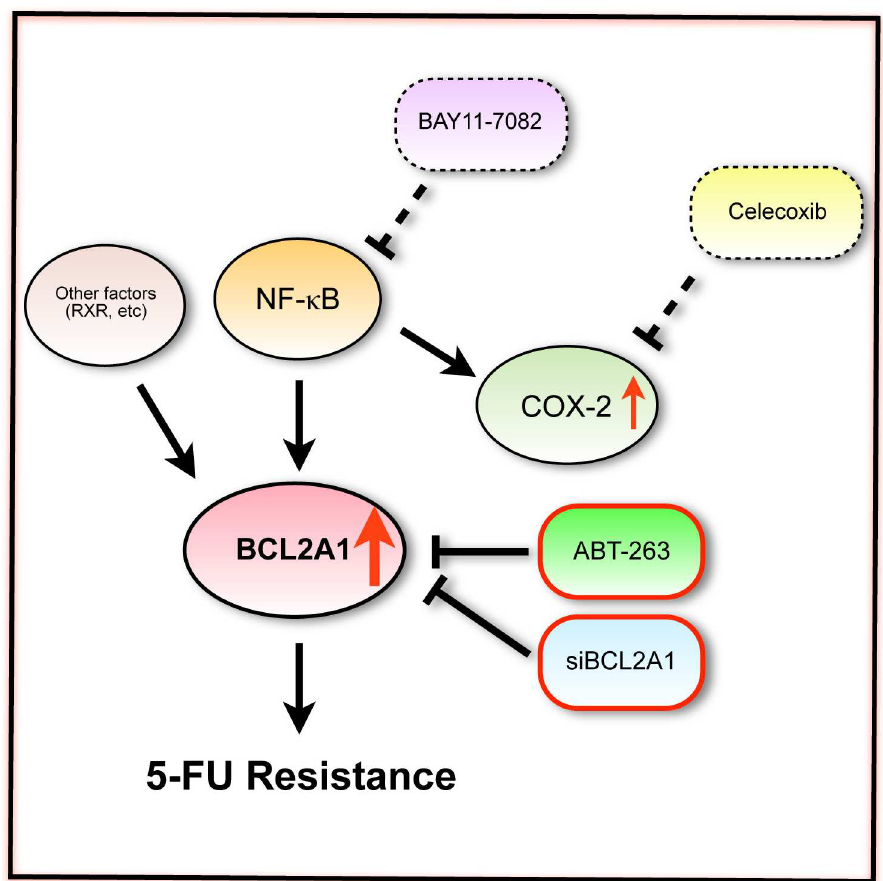
Fig 10. Schematic of the relationship between BCL2A1 , its upstream regulators, and modifiers used in this study. Celecoxibacts on COX-2 but did not regulate BCL2A1 expression, while BAY11-7082 acts directly on NF- κ B and moderatelyregulated BCL2A1 expression, and neither of these sensitized MDA-MB- 231BR to 5-FU. Both ABT-263 and BCL2A1 siRNA directly regulate BCL2A1, and were effective for the sensitization of MDA-MB-231BR to